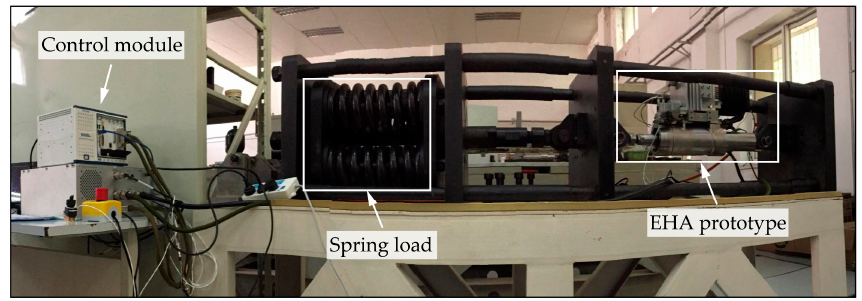
Figure 8. Test bench for the EHA prototype.